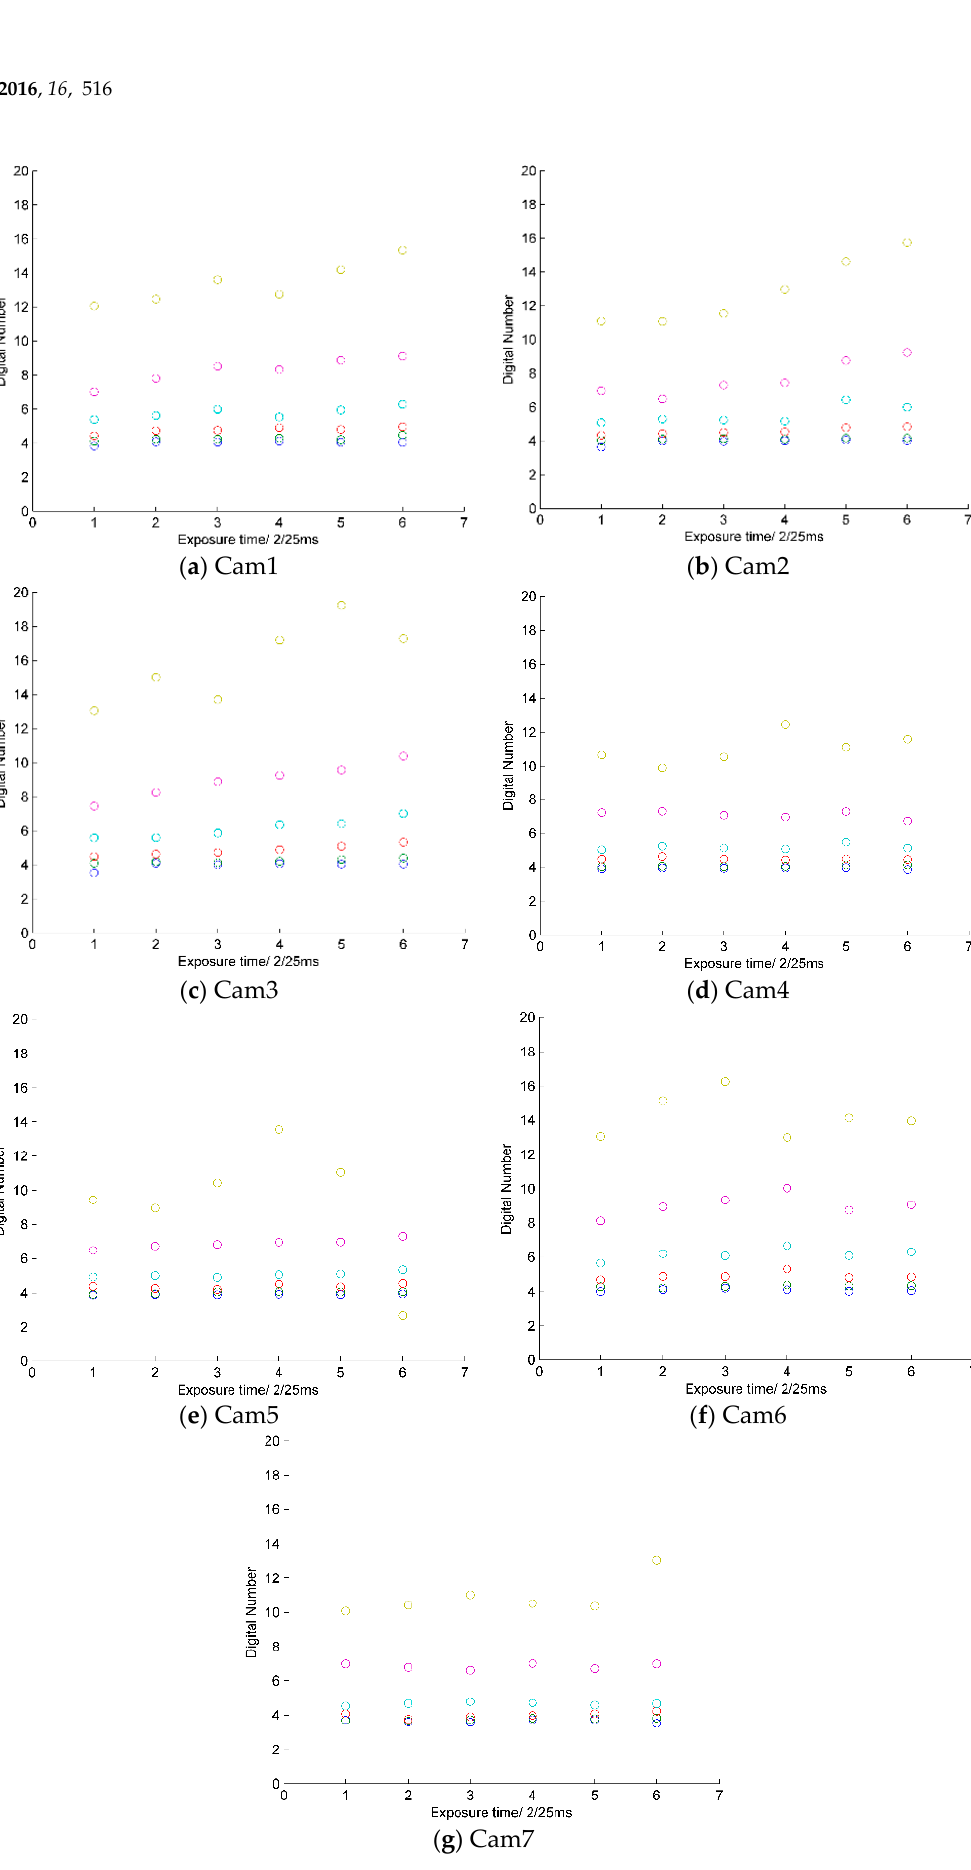
Figure 5. Dark current of seven sensors with six exposure times and six gain settings.